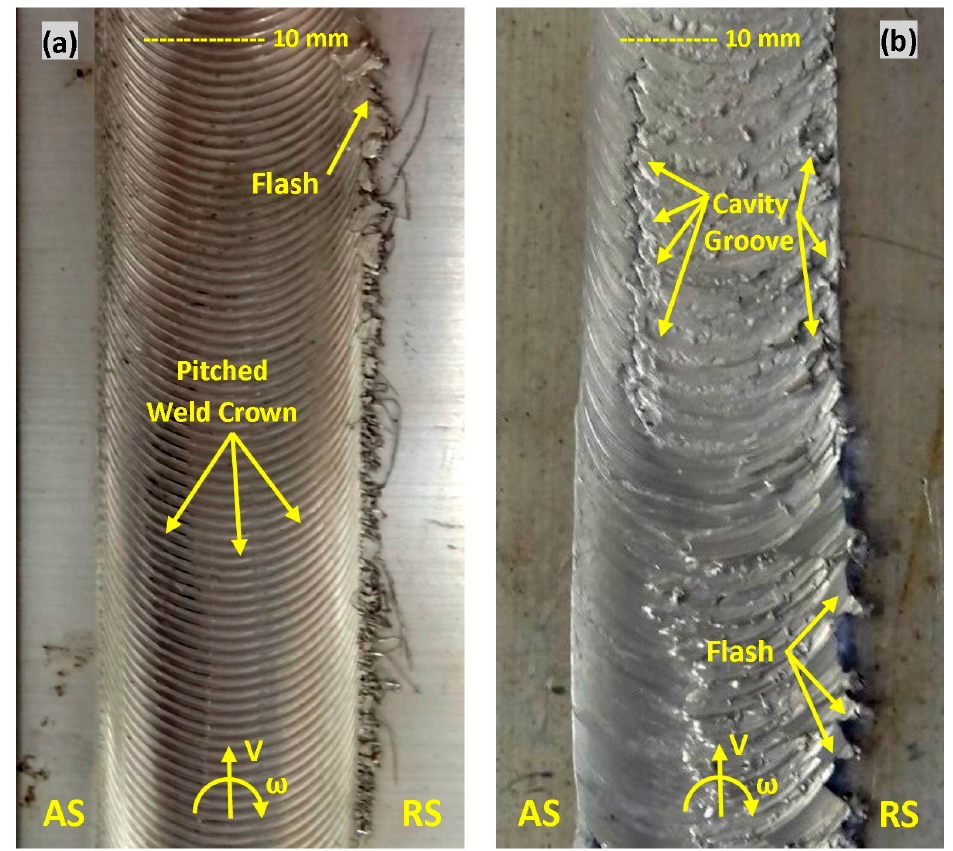
Figure 4. Surface appearance of the weld for conical FSW tool in constant feeding rate; ( a ) at the welding speeds of (1120 rpm and 150 mm/min) and ( b ) at the welding speeds of (1120 rpm and 315 mm/min).